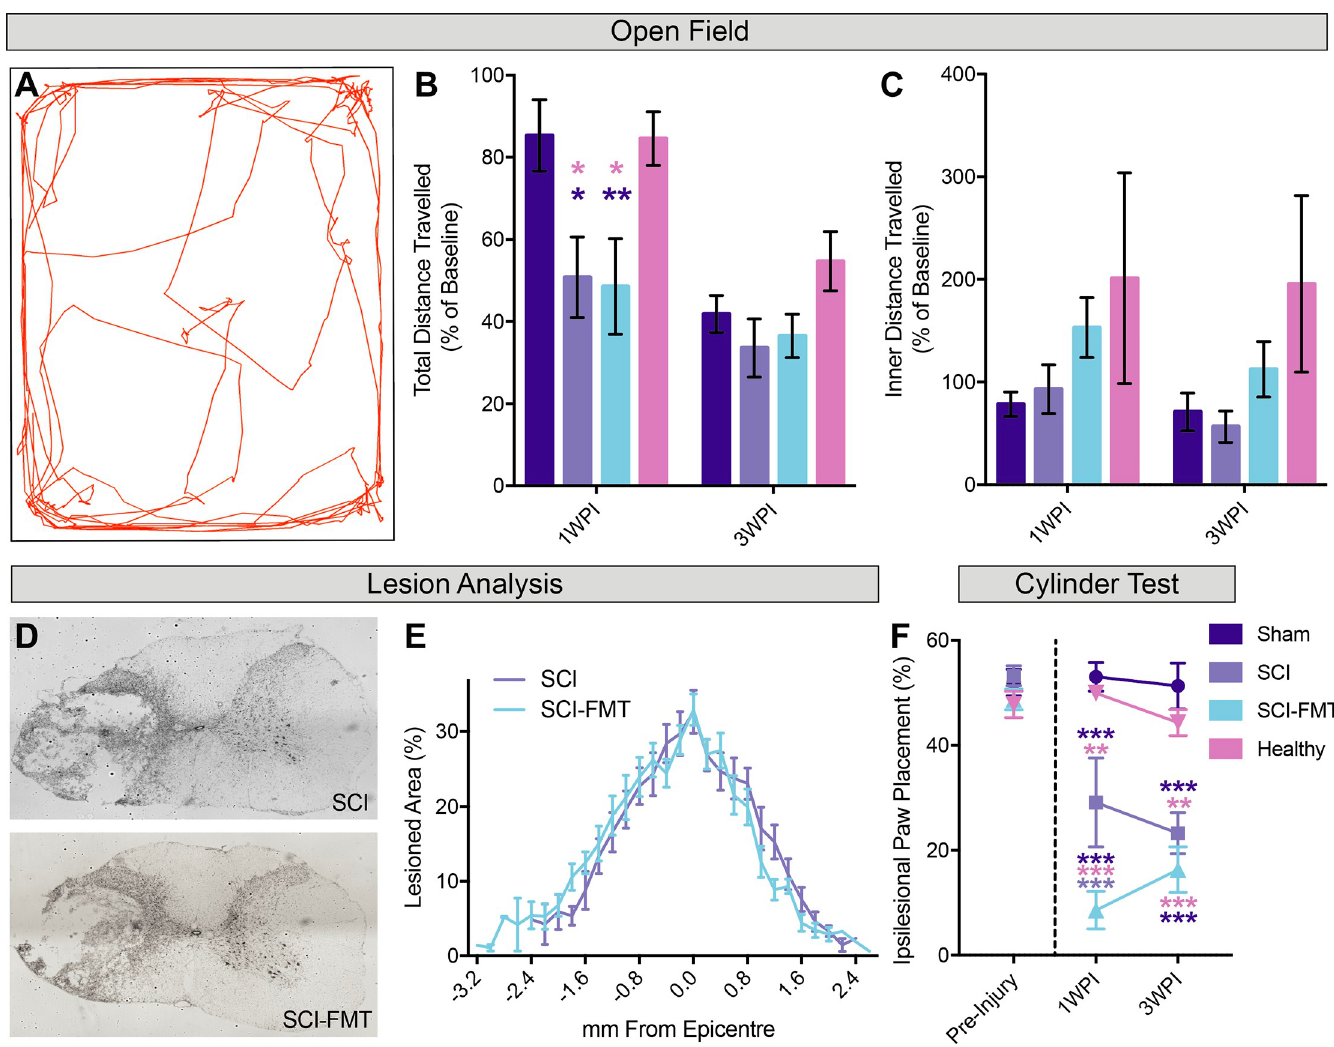
Fig 4. Fecal microbiota transplant did not affect open field behaviour or lesion pathology. Rats were tested in the open field before surgeries, then again 1 week and 3 weeks following later. (A) Representative image from the motion tracking software used to analyze the movement of rats in the open field. (B) 1 week following injury, both SCI and SCI-FMT groups travelled less distance compared to baseline than sham and healthy animals Repeated measure two-way ANOVA: Sham vs SCI p = 0.026, Sham vs. SCI-FMT p = 0.007, SCI vs. Healthy p = 0.036, SCI-FMT vs. Healthy p = 0.011. Sham = 85.33% ± 28.83, SCI = 50.78% ± 30.98, SCI-FMT = 48.58% ± 43.41, Healthy = 84.57% ± 20.6). By 3 weeks following injury there was no difference in the distance travelled in the open field relative to baseline between groups. (C) We next assessed the percent distance travelled in the inner 60% of the arena relative to baseline. At both 1 and 3 weeks following injury there was no difference between groups in the percent inner distance travelled. (D) Representative images of the maximum lesion site from SCI-FMT and SCI groups stained with cresyl violet. (E) There was no significant difference between SCI and SCI-FMT groups in the lesion progression (Mann-Whitney test; p = 0.3688). The average maximum lesion severity for SCI group was 32.67% and 32.95% for SCI-FMT groups. The average lesion extension was 4.06 mm for the SCI group and 3.886 mm for the SCI-FMT group. (F) Sham and Healthy rats did not show any forelimb asymmetry at any time point (Repeated measure two-way ANOVA; Pre-Injury: Sham = 51.97% ± 8.38, Healthy = 47.82% ± 7.94; 1WPI: Sham = 53.05% ± 9.02, Healthy = 49.92% ± 4.90, 3WPI: Sham = 51.33% ± 14.47, Healthy = 44.35% ± 7.86). Prior to SCI, rats did not display any contralateral bias in their paw placements in the cylinder test (SCI = 53.26% ± 5.66, SCI-FMT = 48.75% ± 7.20). 1 week post-injury, SCI and SCI-FMT rats made significantly fewer ipsilesional (right) paw placements than Healthy and Sham animals. At one week post injury, the SCI-FMT group had a more significant contralateral bias in their paw placements than the SCI group (SCI vs. SCI-FMT p = 0.0008). 3 weeks after injury, the differences between SCI and SCI-FMT groups were abolished, with all SCI animals making fewer ipsilesional paw placements than uninjured groups (Sham vs. SCI p = 0.0001 (1WPI & 3WPI), sham vs. SCI-FMT p < 0.0001 (1WPI & 3WPI), SCI vs. Healthy p = 0.0015 (1WPI) p = 0.0013 (3WPI), SCI-FMT vs. Healthy p < 0.0001 (1WPI & 3WPI). 1WPI: SCI = 29.12% ± 25.33, SCI-FMT = 8.59% ± 12.93; 3WPI: SCI = 23.29% ± 11.8, SCI-FMT = 16.33% ± 15.66). Error bars indicate standard error mean. � p < 0.05, �� p < 0.01, �� p < 0.001.